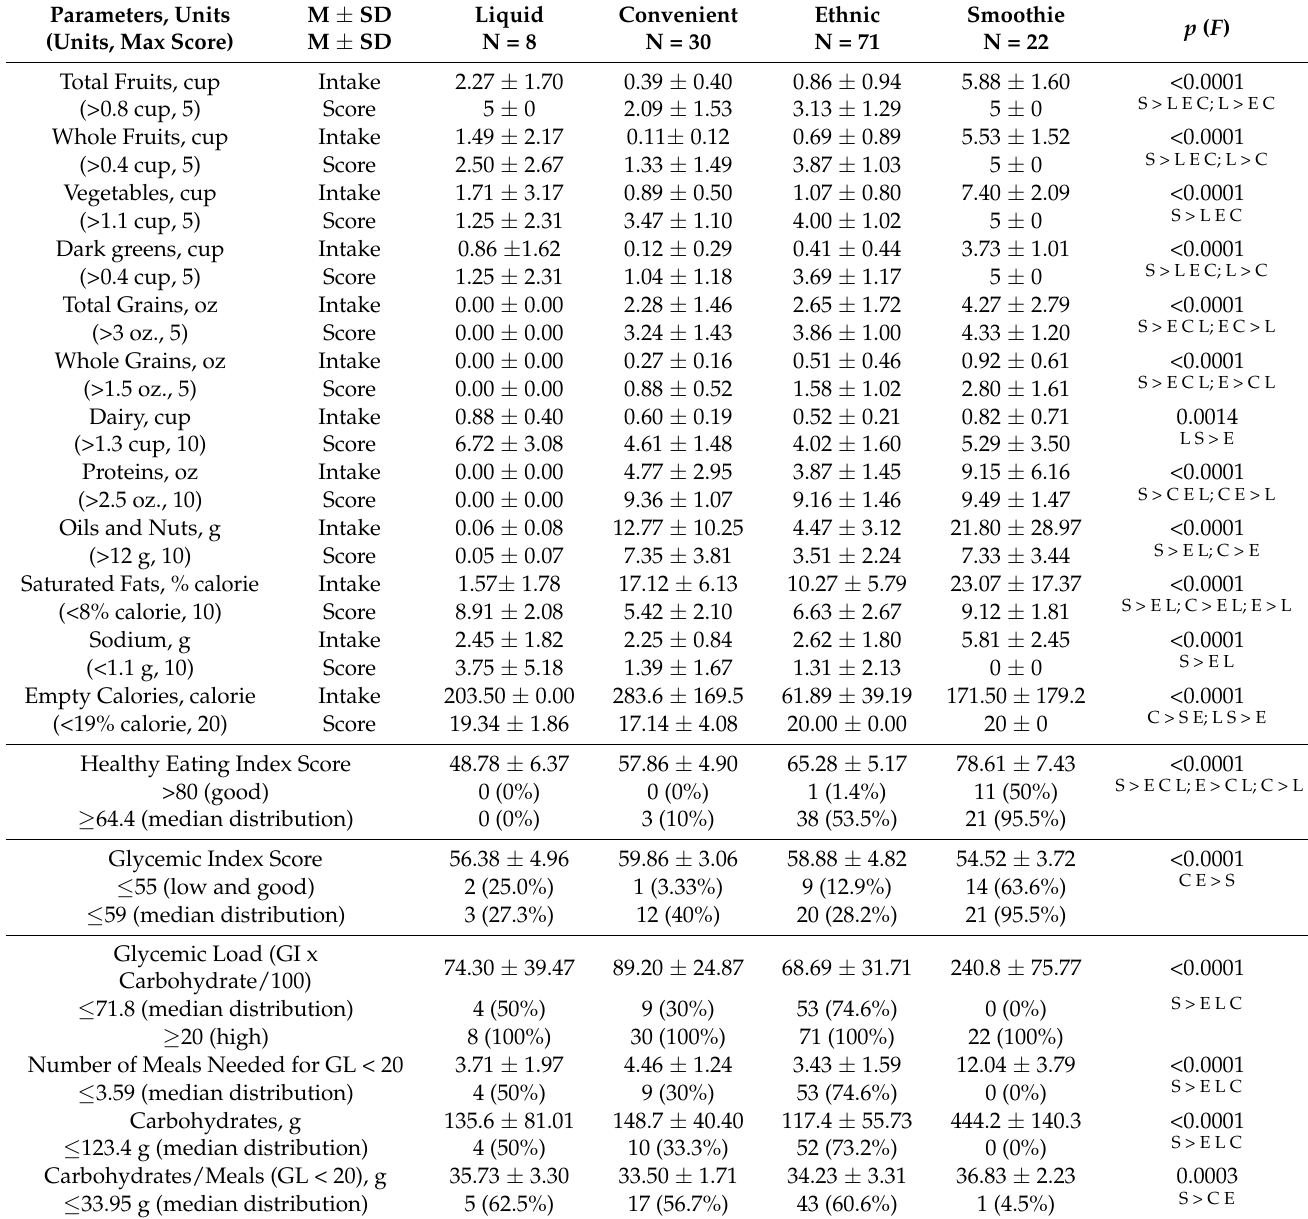
Table 1. Healthy eating parameters per four groups of diets per daily meals ( N =